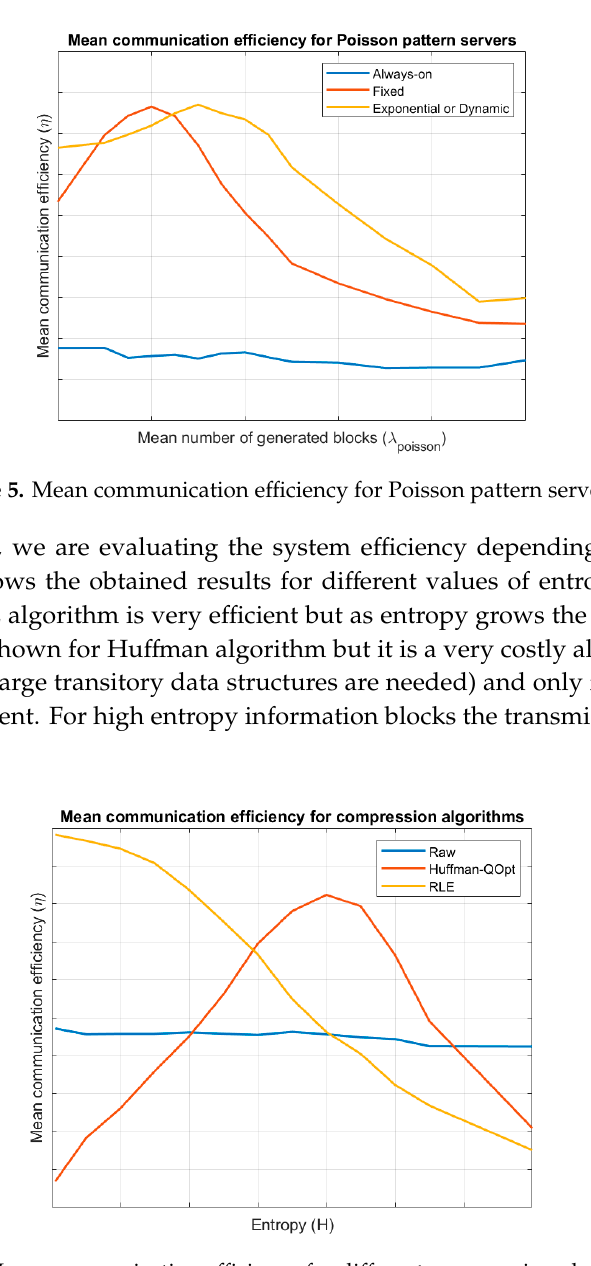
Table 7. Application limits for each compression algorithm.